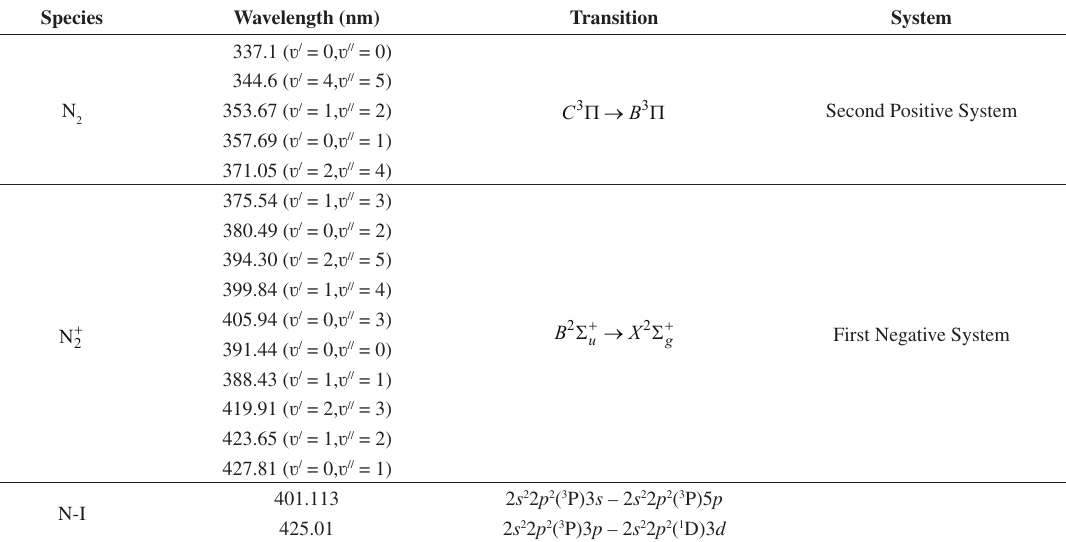
Figure 2. Emission spectra of N 330-372 nm (b) 372-430